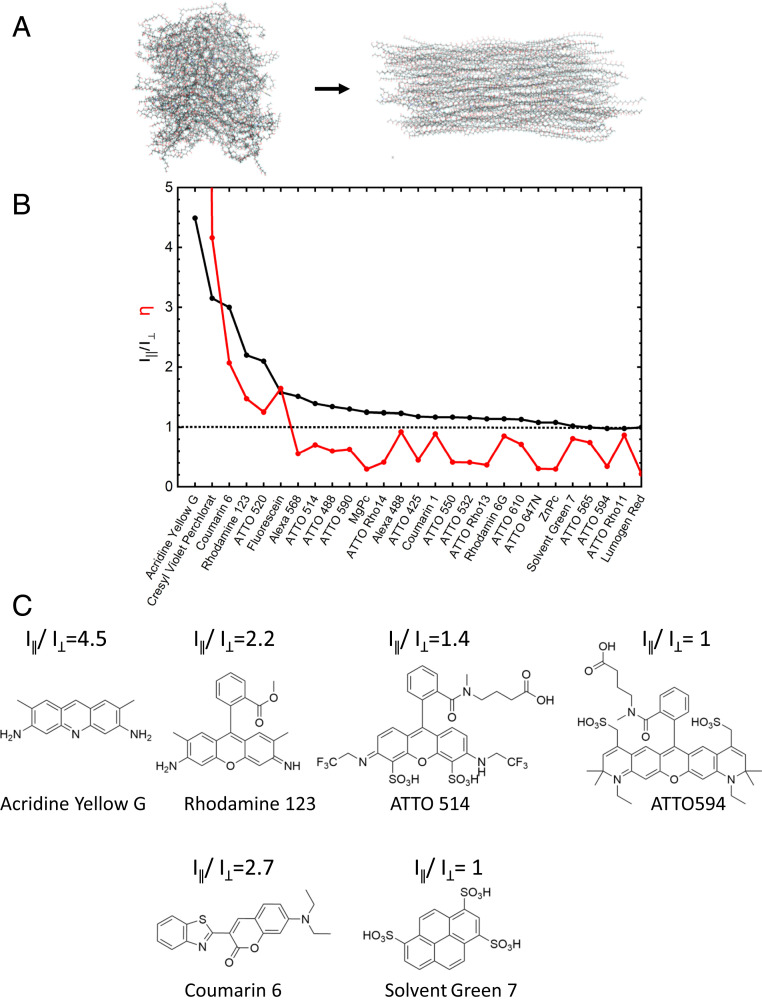
Alignability of different molecules in stretched polymers. (A) Visualization of a model system of polyvinyl alcohol polymer before and after stretching by a factor of ∼500%, based on molecular dynamics simulations. (B) Experimental alignabillty of the transition dipole moment of different molecules determined by fluorescence polarization observed parallel and perpendicular to the stretching direction, I∥/I⊥ (black, Eq. 1) and structural predicting factor η determined from the numbers, NBand, and NOutOfBand as defined in the text (Eq. 2). A value of η > 1 predicts molecular alignability. (C) Exemplary molecular structures and corresponding alignabilities I∥/I⊥ of six typical dyes.